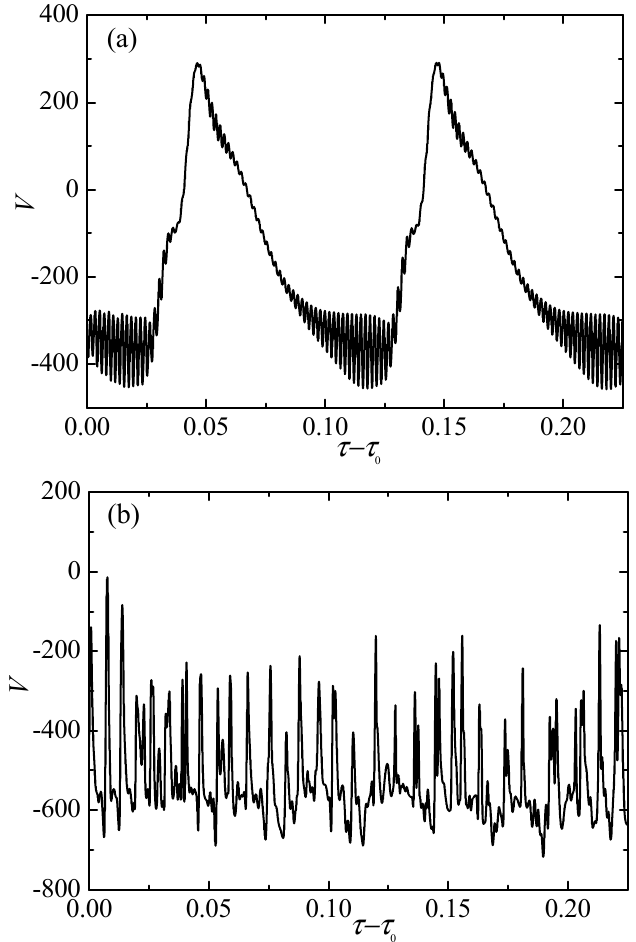
Figure 6. The time dependencies of azimuthal velocity V at the monitoring point P ( R = 0.75, Z = 0.5, θ = 0) when Re c = 0 and Re T = 10 4 . ( a ) Re s = − 1.8 × 10 3 ; ( b ) Re s = − 2.3 × 10 3 .